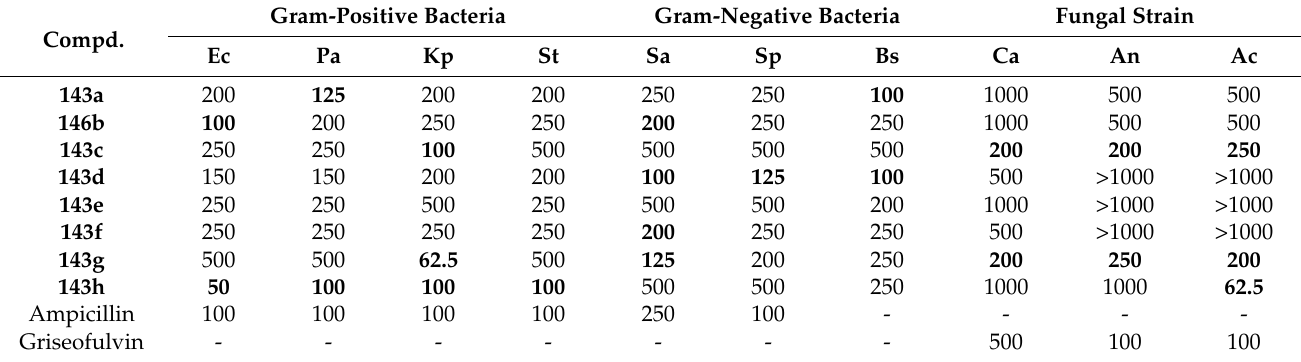
Table 7. Minimal inhibition concentration (µg mL − 1 ) of hybrids 143a − 143h [61]. Compd.